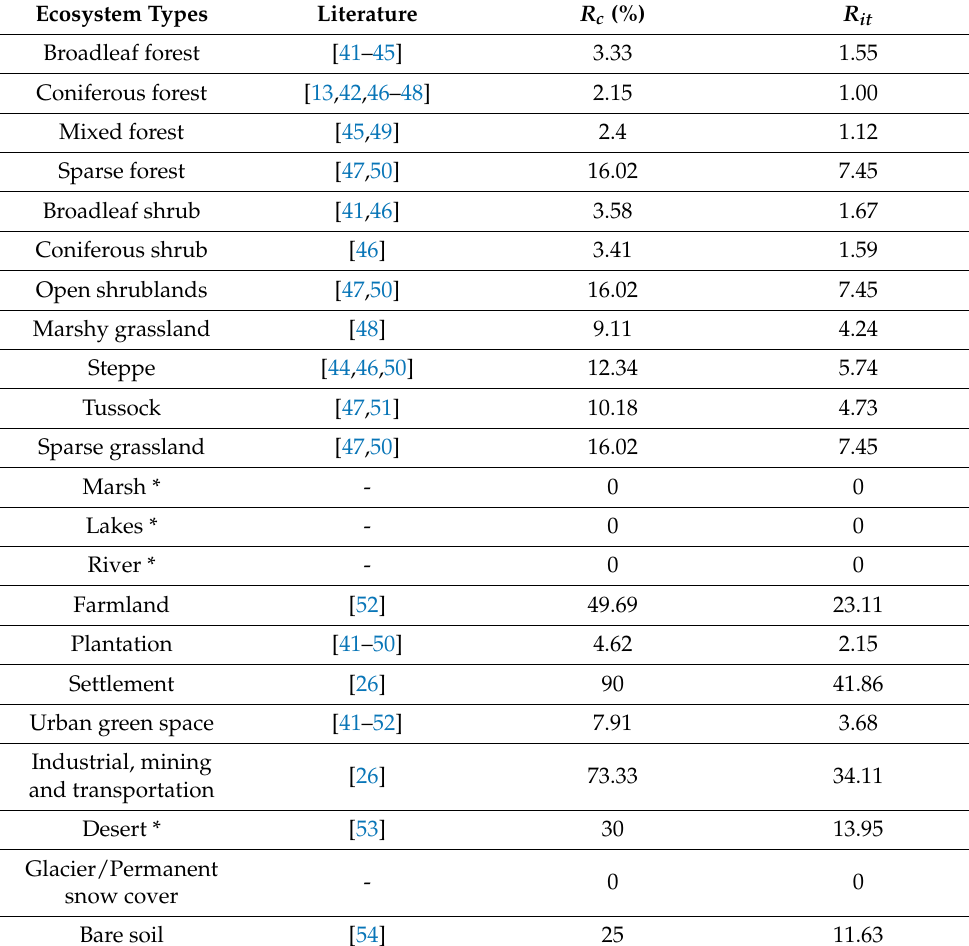
Table 1. Runoff coefficient ( R c ) and runoff index of type ( R it ).